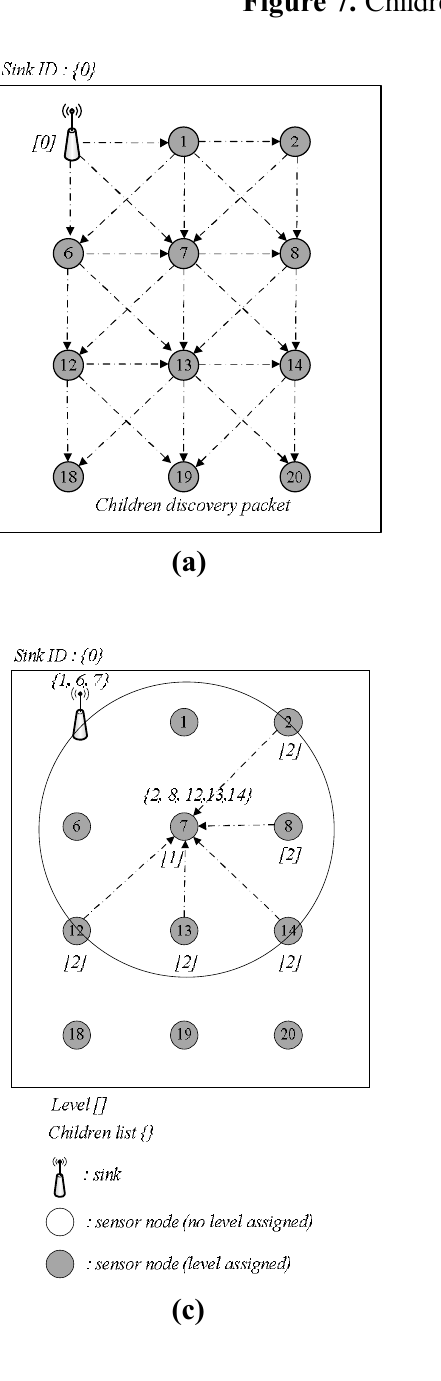
Figure 7. Children discovery